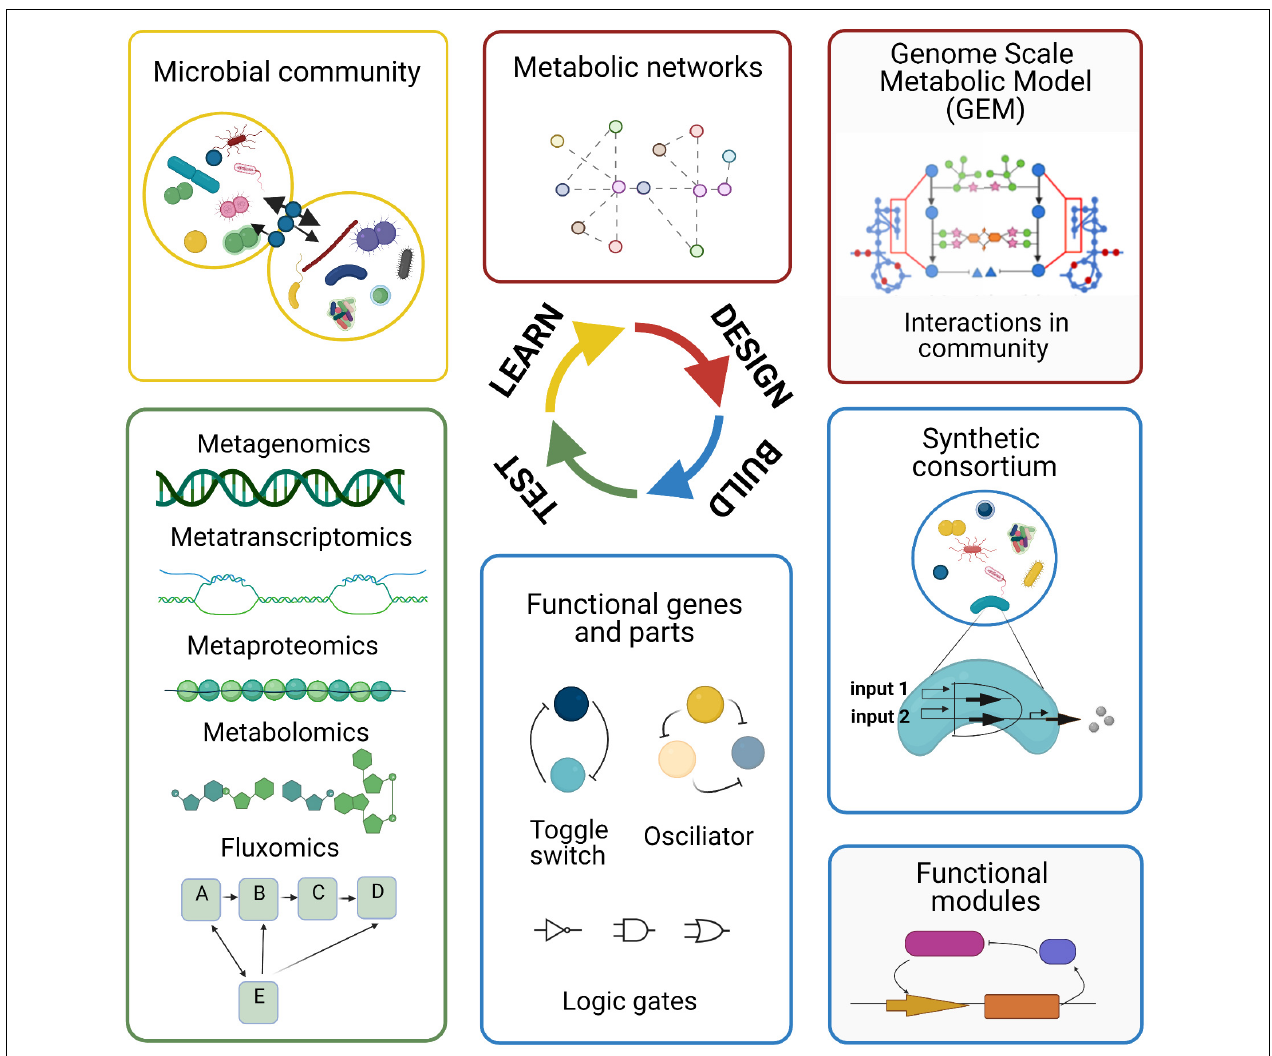
FIGURE 2 | Advantages and limitations of omic technologies used in microbiome research. The different omic techniques allow for the measurement of different features (the genome, transcriptome, proteome, and metabolome) within a biological sample. After data generation, the data are processed and analyzed using bioinformatic